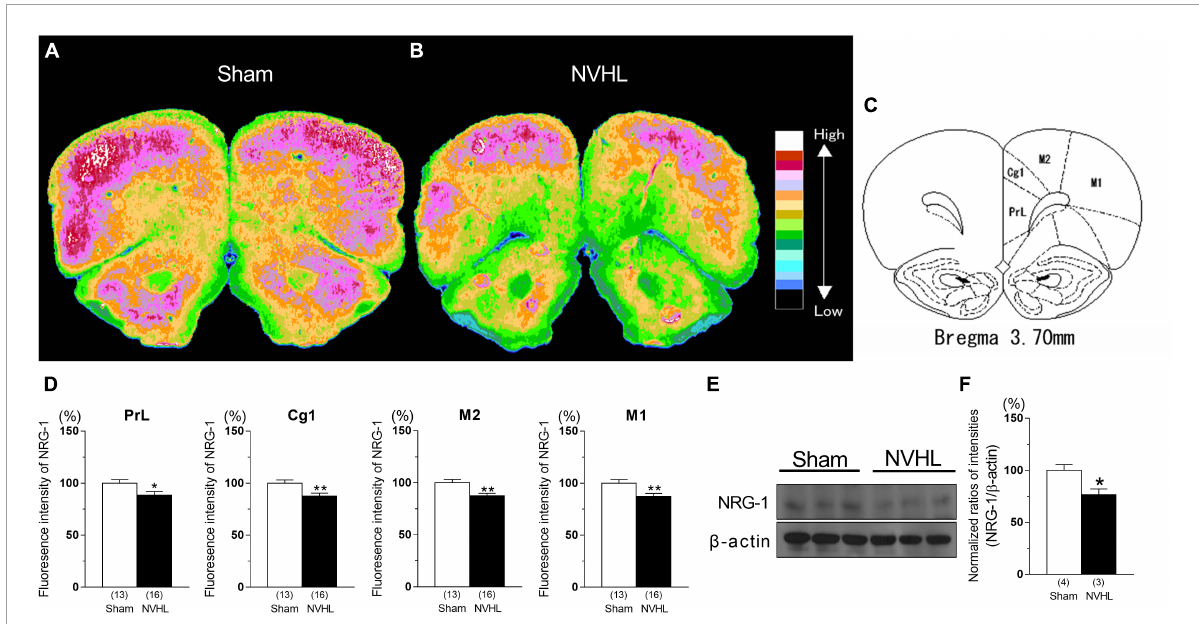
FIGURE2 Reduced NRG-1 levels in the PFC in the NVHL rats at post-pubertal period. Immunohistochemical fluorescence intensity for NRG-1 in PFC. (A) Sham rat. (B) NVHL rat. (C) Diagram showing the prelimbic cortex (PrL), cingulated cortex area 1 (Cg1), secondary motor cortex (M2), and primary motor cortex (M1). (D) Values for the immunofluorescence intensity for NRG-1 in PrL, Cg1, M2, and M1. The distribution of NRG-1 fluorescence intensity in each rat PFC section was determined by microphotometry and classified into 16 levels [as indicated by color in panel (A,B) , with lowest concentration in black and highest concentration in white]. Representative immunoblots probed with antibodies against NRG-1 and β -actin, as indicated (E) . Quantification of the normalized values of NRG-1 levels with β -actin (F) . Numbers in square brackets indicate the number of animals in each group. Bars represent means ± SEM. * p < 0.05 and ** p < 0.01 vs. sham group.